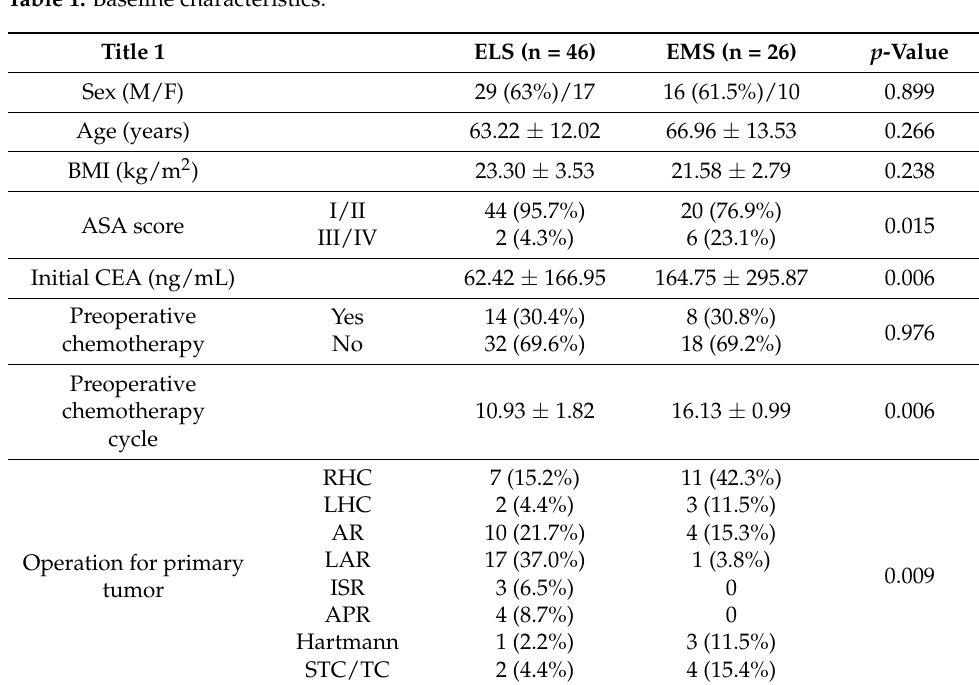
Figure 1. Flow diagram CRC, colorectal cancer; PTR, primary tumor resection. Table 1. Baseline